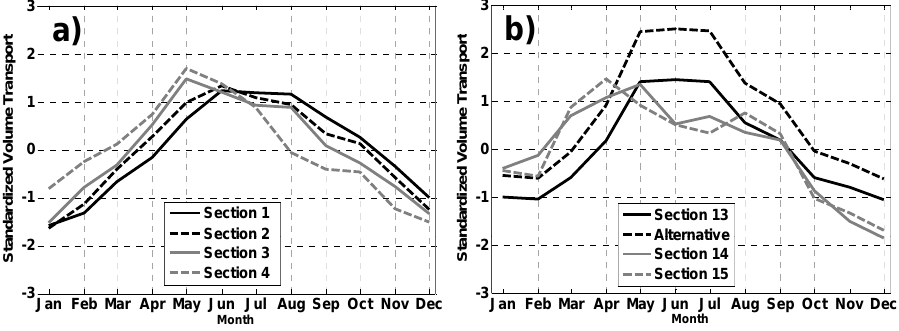
Fig. 9. Standardized annual cycle of the bottom-layer volume transport for the entire OCCAM simulation in (a) Weddell and (b) Ross Seas cross-slope sections as indicated. The units are point-wise normalized and represent the number of standard deviations from the overall